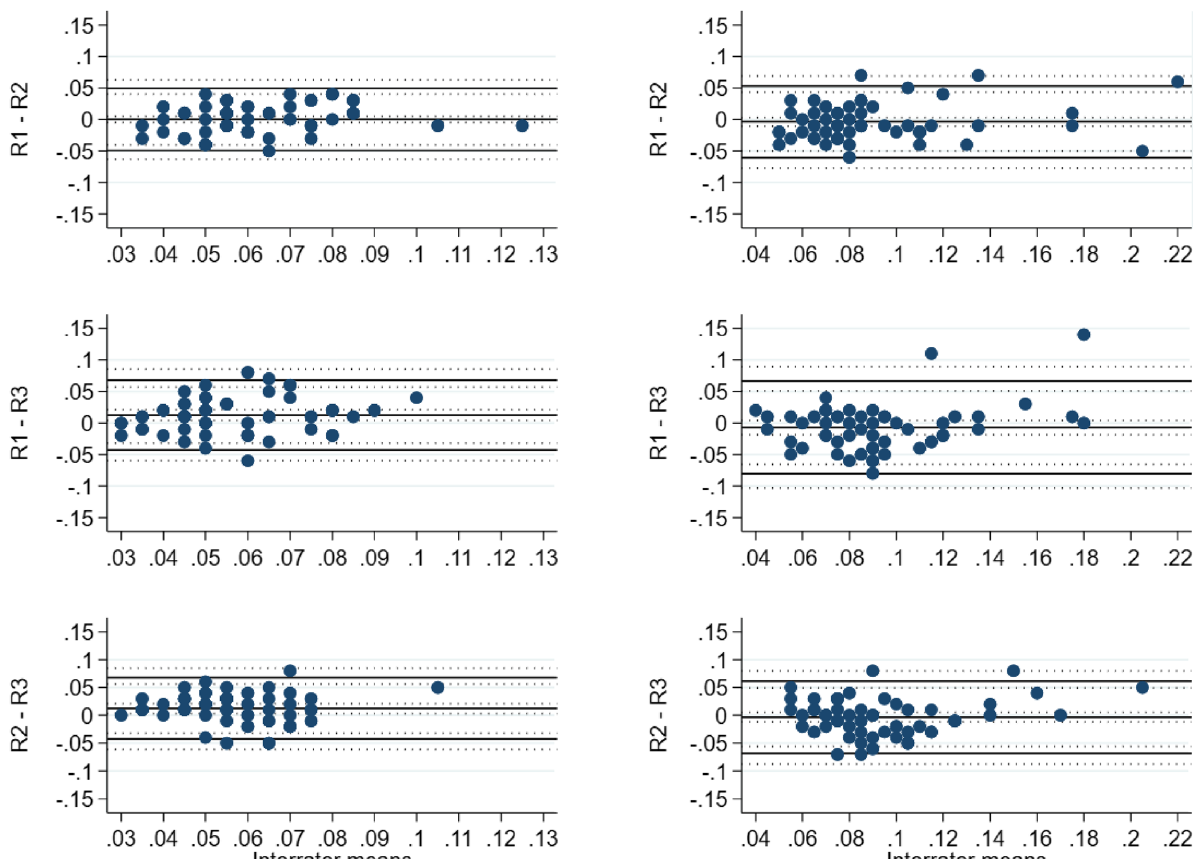
Figure 5. BA LoA plots showing the interrater agreement analysis for plethysmometer [ml]. Left panel: control. Right panel: lymphedema. BA LoA Bland–Altman Limits of Agreement, ml milliliters, R1 rater 1, R2 rater 2, R3 rater